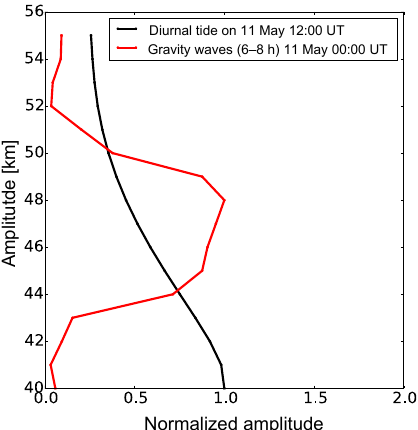
Figure 11. Normalized wavelet amplitudes of the diurnal wave component and of the gravity waves from the temporally filtered data on 11 May at 12:00UT (00:00UT) as a function of